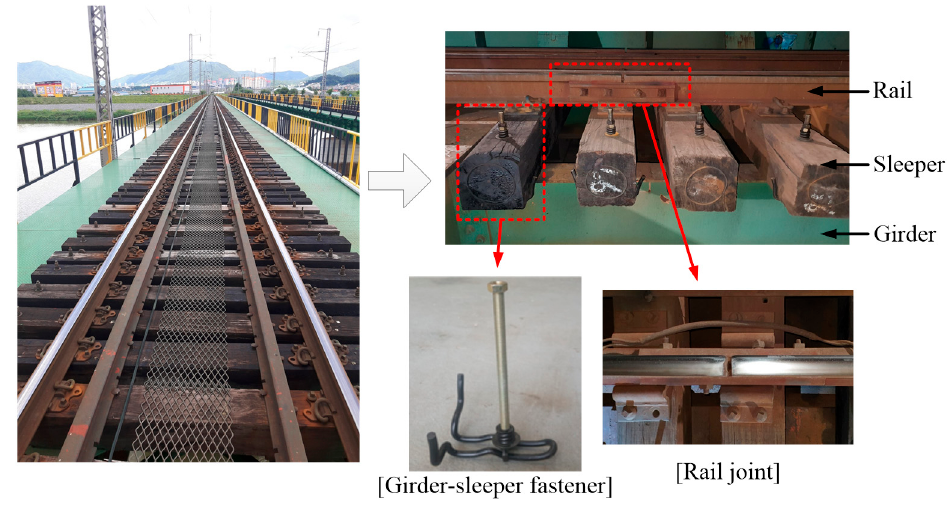
Figure 1. Example of open-deck steel plate girder bridge.